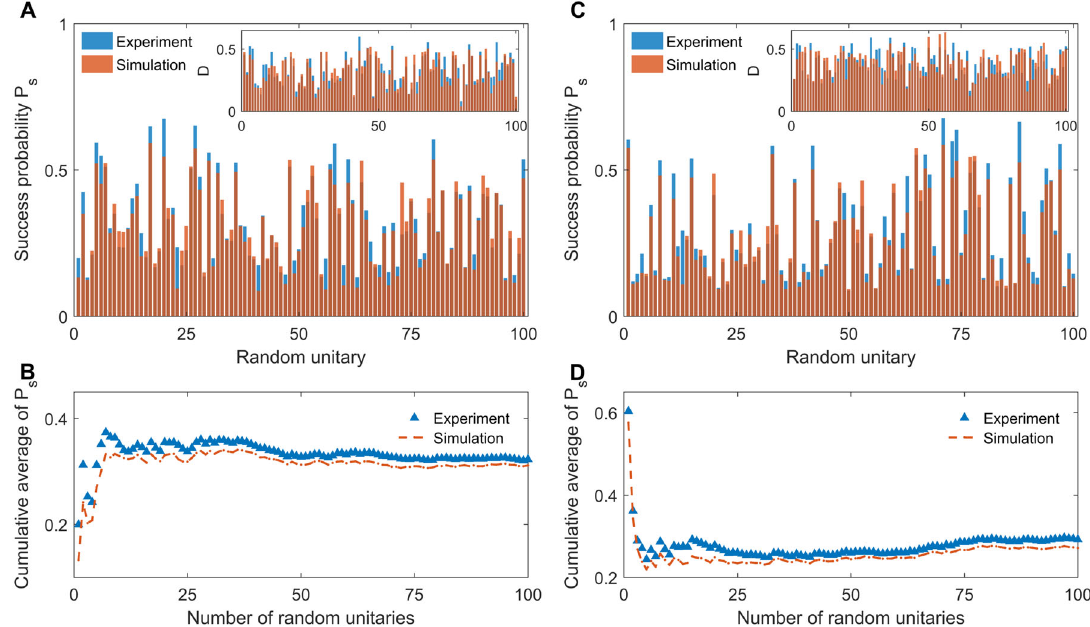
Fig. 4 Success probability of random unitaries for different initial states. The random unitaries are realized as U r shown in ( c ), where 12 random single-qubit gates are applied before and after a CZ gate. Experimental results are shown in blue; simulated values are in brown. In the simulation, decoherence effect is considered (see “ Method ” ). As shown in case 3 of Table. 1, the free-evolution Hamiltonian is I . In ( a ) and ( b ), the initial state is (cid:2)j i , and in ( c ) and ( d ), the initial state is 1 j i . For these two different initial states, the random unitary sets are also different. a , c Success probabilities for each of the 100 random unitaries; inset: the trace distances for each unitary. The experimental and simulated results are shown in blue and brown bars, respectively. b , d Cumulative average of success probabilities. The experimental and simulated results are shown in blue triangles and brown dashed line,